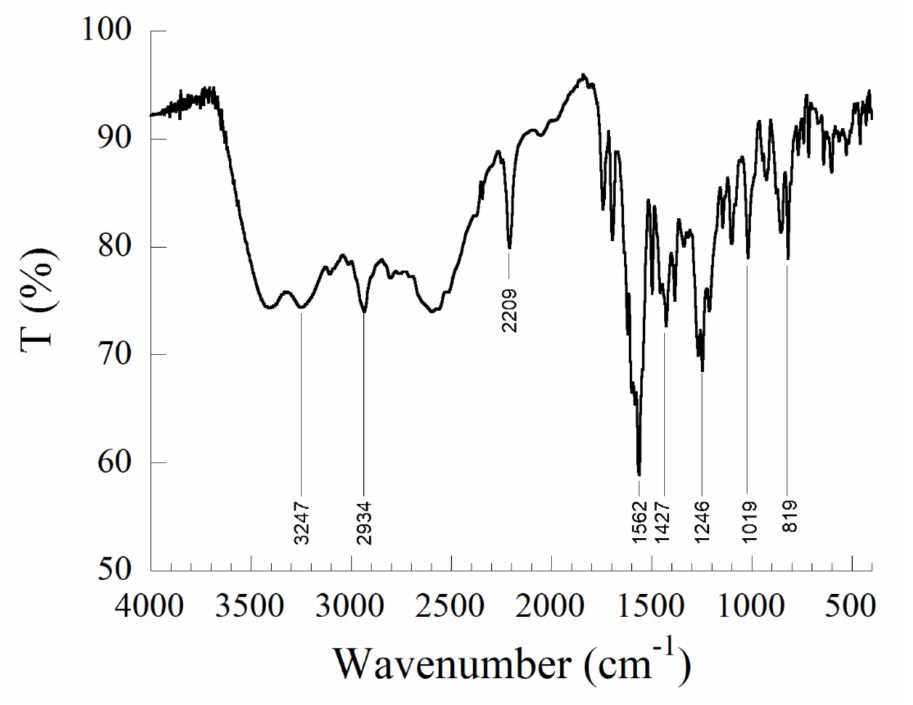
Figure 5. FTIR spectrum of